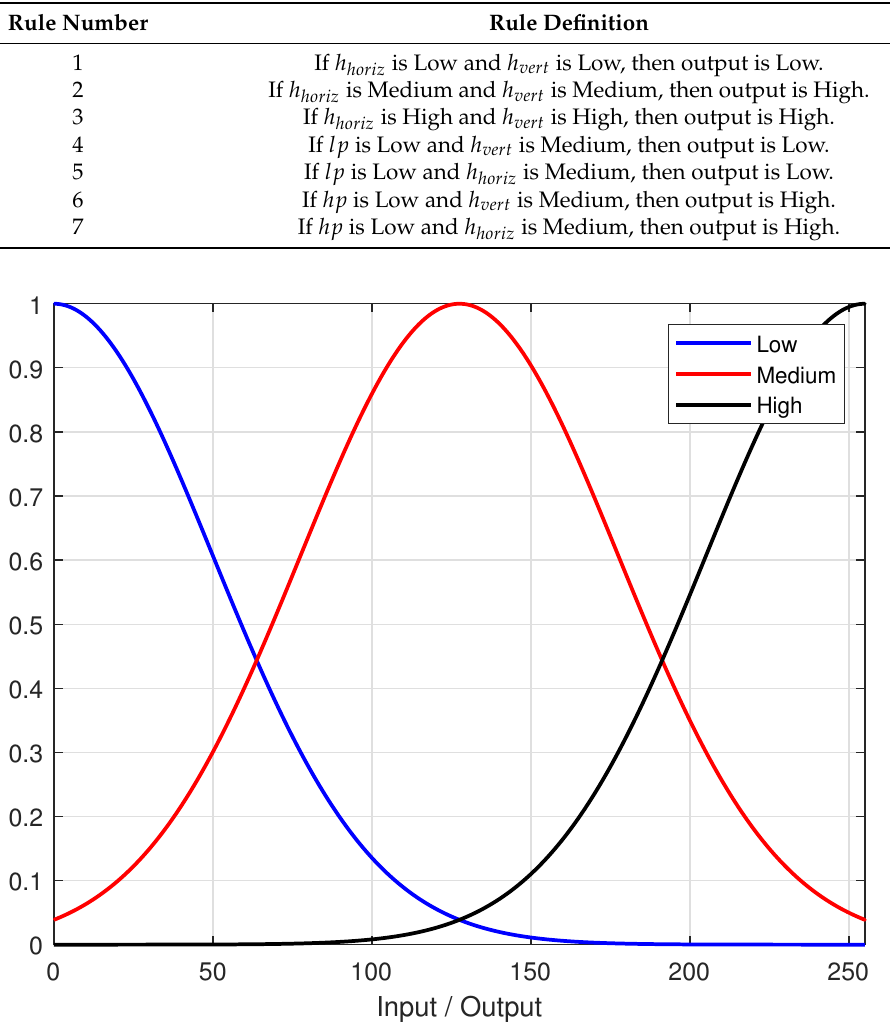
Figure 3. The MFs of all the inputs and the output. The fuzzy model detects the edges of the image in the range from 0 to 255. It is known that in the grayscale format, 255 corresponds to white and 0 means black, and therefore, the closer a pixel is to 255, the greater the probability of the pixel being identified as an edge pixel. Figure 4 illustrates the developed fuzzy inference system for this paper.